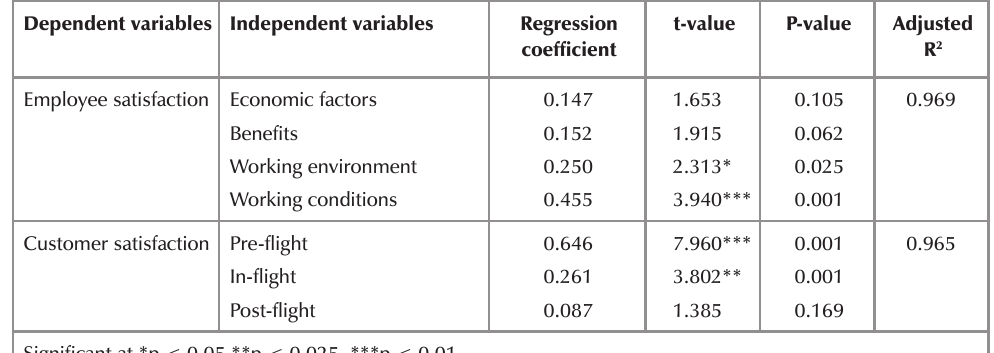
Results of single and multiple regression